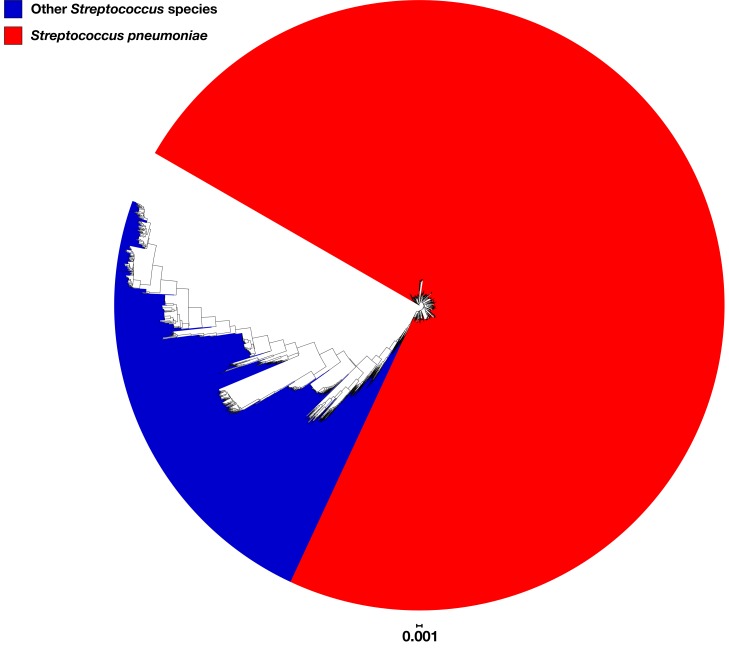
Phylogenetic tree constructed based upon the sequences of 53 ribosomal gene sequences extracted from the 3,118 pneumococcal study genomes plus 1,000 genomes of 65 different non-pneumococcal Streptococcus spp. genomes. Pneumococcal and non-pneumococcal clusters are colored red and blue, respectively.